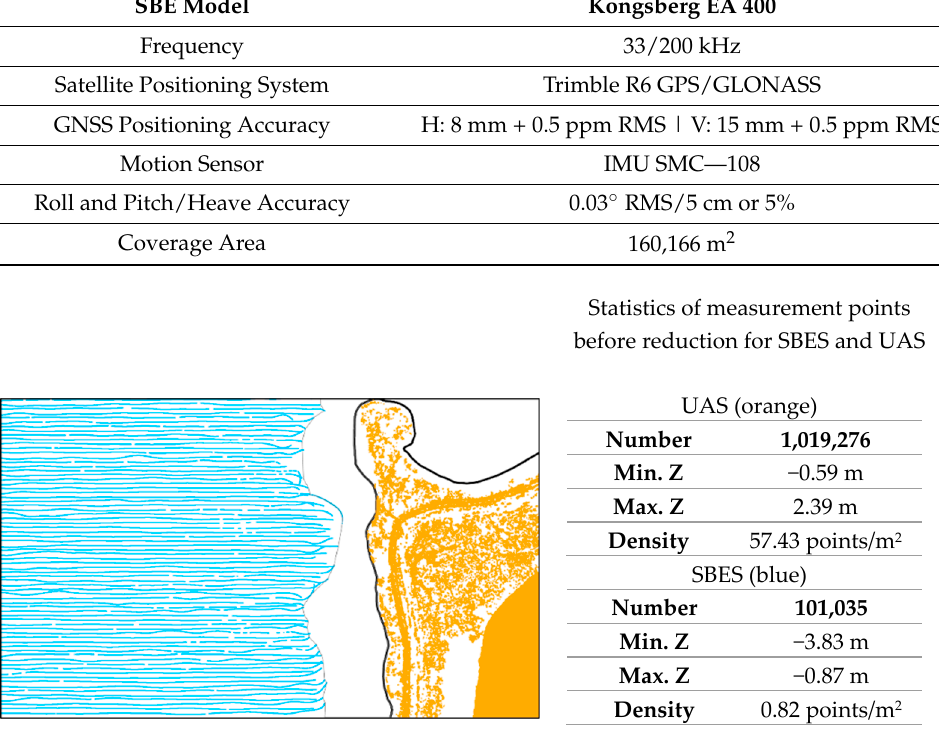
Figure 2. Spatial distribution and statistics of measurement data.